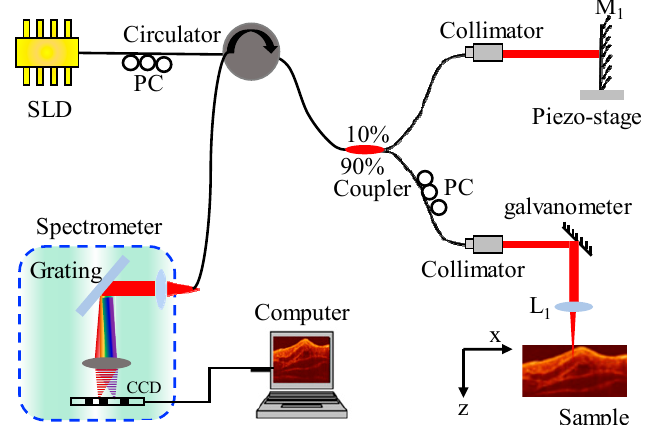
Figure 3. Schematic diagram of the SD-OCT system. L 1 : focused lens; PC: fiber polarization controller;